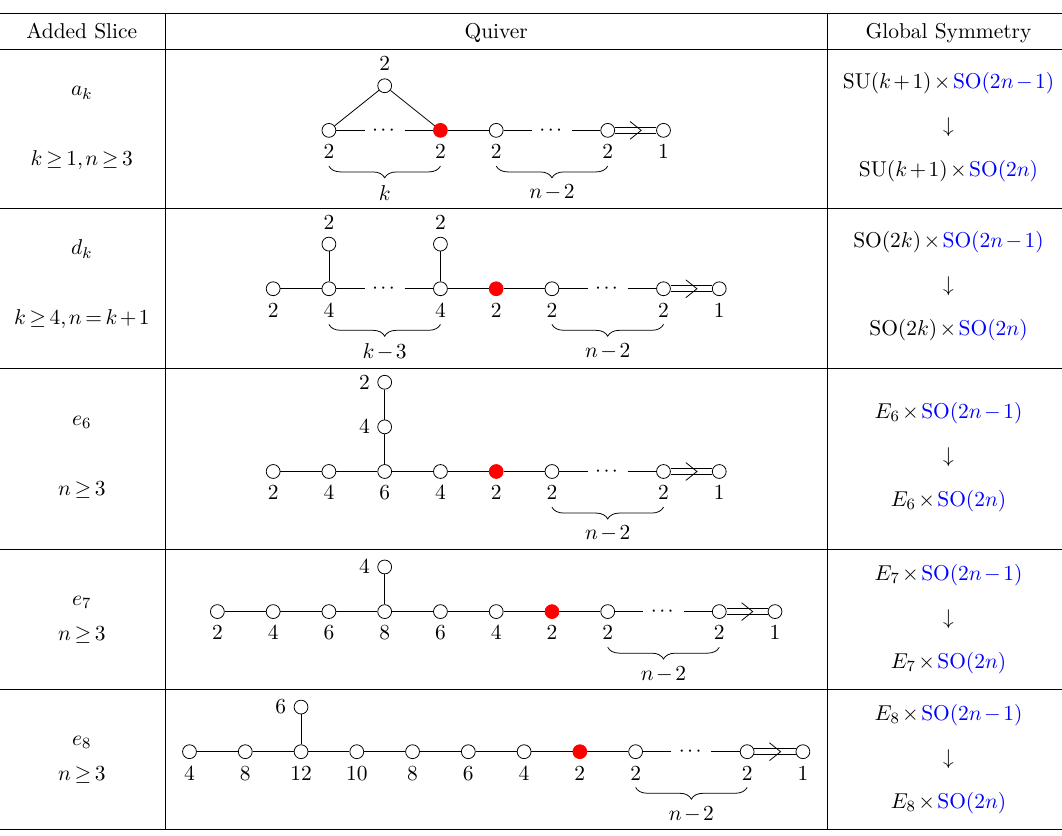
Table 17 . Quivers resulting from adding all possible simply laced slices to the empty nodes of n.min D (6.1) to absorb a for n ≥ 3 n